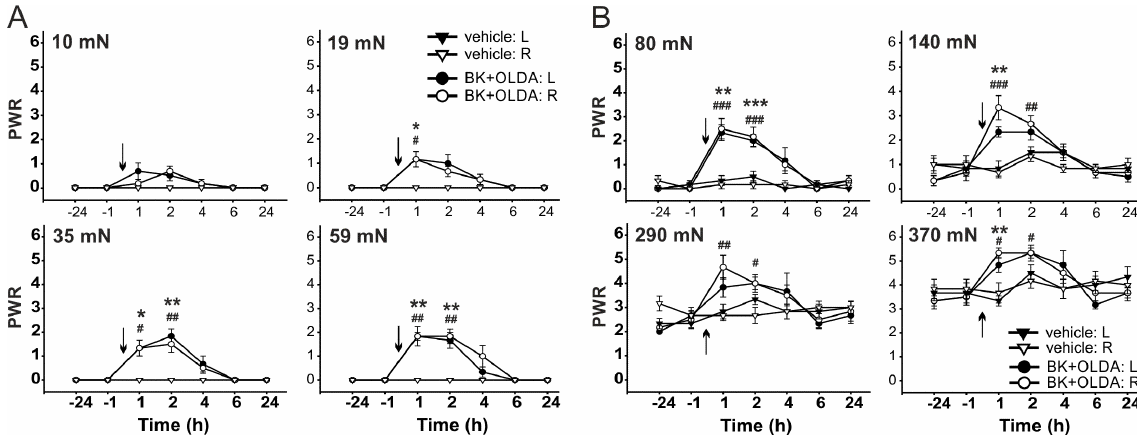
Figure 5. Intrathecal BK administration-induced mechanical hypersensitivity was enhanced by OLDA co-administration. Low dose of OLDA (0.42 µg) and BK (21.2 µg, i.t., n = 6) co-administration protracted BK-induced mechanical allodynia using the von Frey filaments, with bending forces of 35 mN and 59 mN ( A ), and hyperalgesia using filaments with bending forces of 80 mN, 140 mN, 290 mN, and 370 mN ( B ). Data represent the mean ± S.E.M. of 6 (BK + OLDA) and 6 (vehicle) independent experiments. Statistical analysis: Mann-Whitney rank test; * p < 0.05, ** p < 0.01, *** p < 0.001 left hindpaw, BK + OLDA versus vehicle treatment; # p < 0.05, ## p < 0.01, ### p < 0.001 right hindpaw, BK + OLDA versus vehicle treatment. The time of the i.t. administration is marked by arrows.